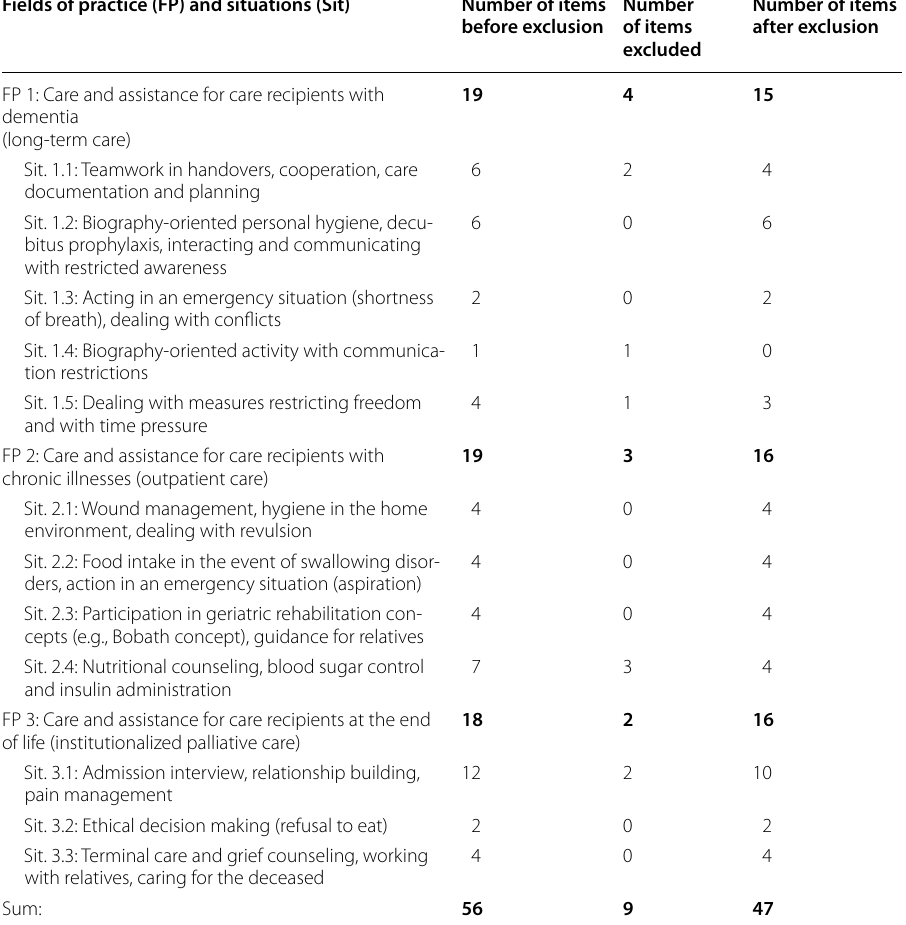
Table 5 Item distribution across fields of practice and situations before DIF analysis and after exclusion Fields of practice (FP) and situations (Sit) Number of items